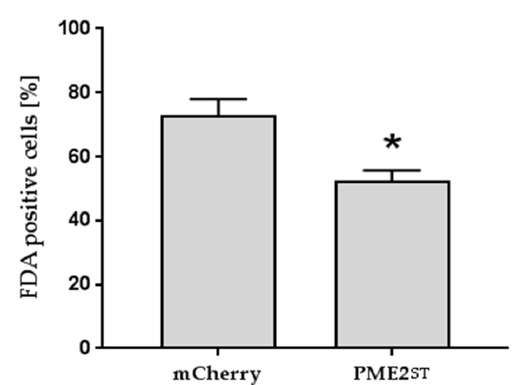
Figure 6. PME2 ST overexpression reduces viability of N. benthamiana mesophyll protoplasts. Mesophyll protoplasts were transformed with the plasmid pGGZ001 encoding mCherry-tagged PME2 ST (PME ST ) or the mCherry tag only (mCherry) and stained with fluorescein diacetate (FDA) to detect viable cells. Data represent the mean percentage of FDA-positive stained cells +/– SE ( n = 3). The statistical difference between the two groups was determined by using a Student’s t -test and is indicated with an asterisk (* p < 0.05).